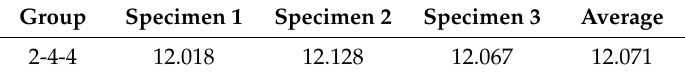
Figure 19. The static tensile tests using INSTRON 5985 universal testing machine. Table 7. The tests result of static tensile failure load 𝐹 (cid:3029) (unit: KN).